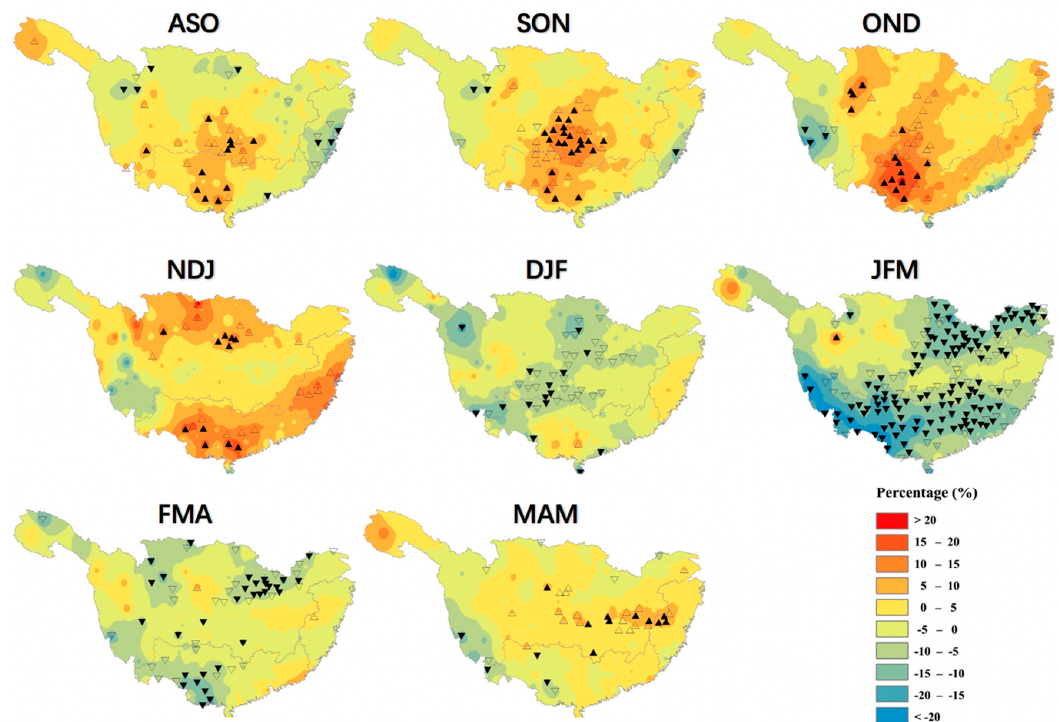
Figure 4. Intentionally biased bootstrapping simulations of three-month moving average precipitation from ASO to MAM (refer to Section 2.2 for definitions) over southern China in the case of DMI + 1 SD, excluding El Niño years: Here, DMI + 1 SD represents the case in which the DMI is intentionally increased by a +1-SD departure from the long-term average (1961–2017) to assess the impact of IOD events on seasonal total precipitation. In each figure, percentage changes in seasonal precipitation are shown in red (blue) for increases (decreases). The weather stations showing statistically significant increases and decreases are indicated with regular and inverted triangles, respectively. In addition, the results of applying 90% and 95% confidence levels are marked by unfilled and filled symbols, respectively.